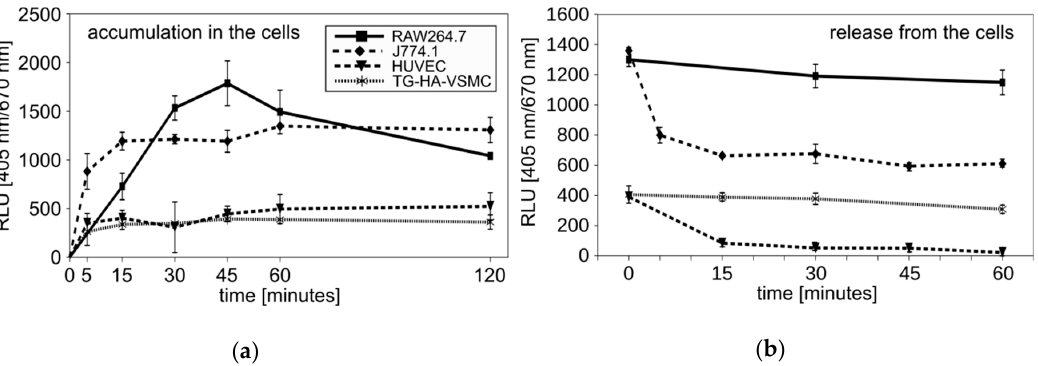
Figure 6. ( a ) The accumulation of Photolon inside the indicated cell lines over time. Average relative light units (RLU) ± SD are shown. ( b ) Release of Photolon formulation from the cells after 15 min of accumulation. Average RLU ± SD are shown.